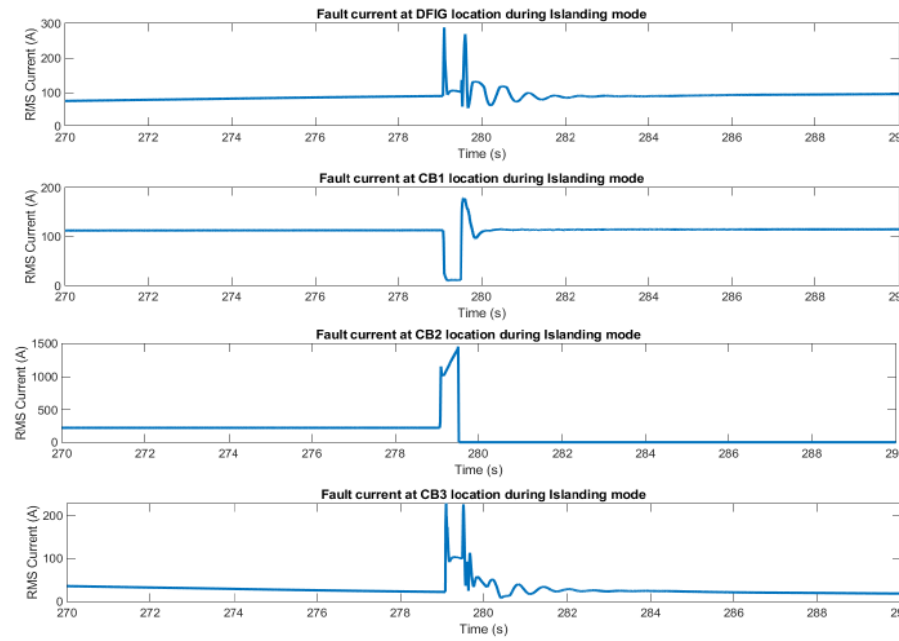
Figure 17. Selectivity of tripping CB2 for fault 2 integrating MAPS.